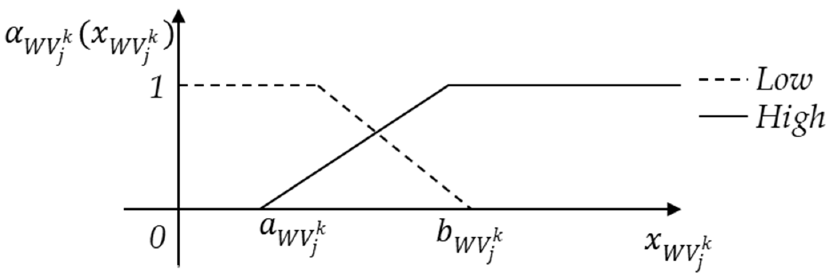
Figure 3. The membership function of the linguistic variable of the irregularity waste stream.